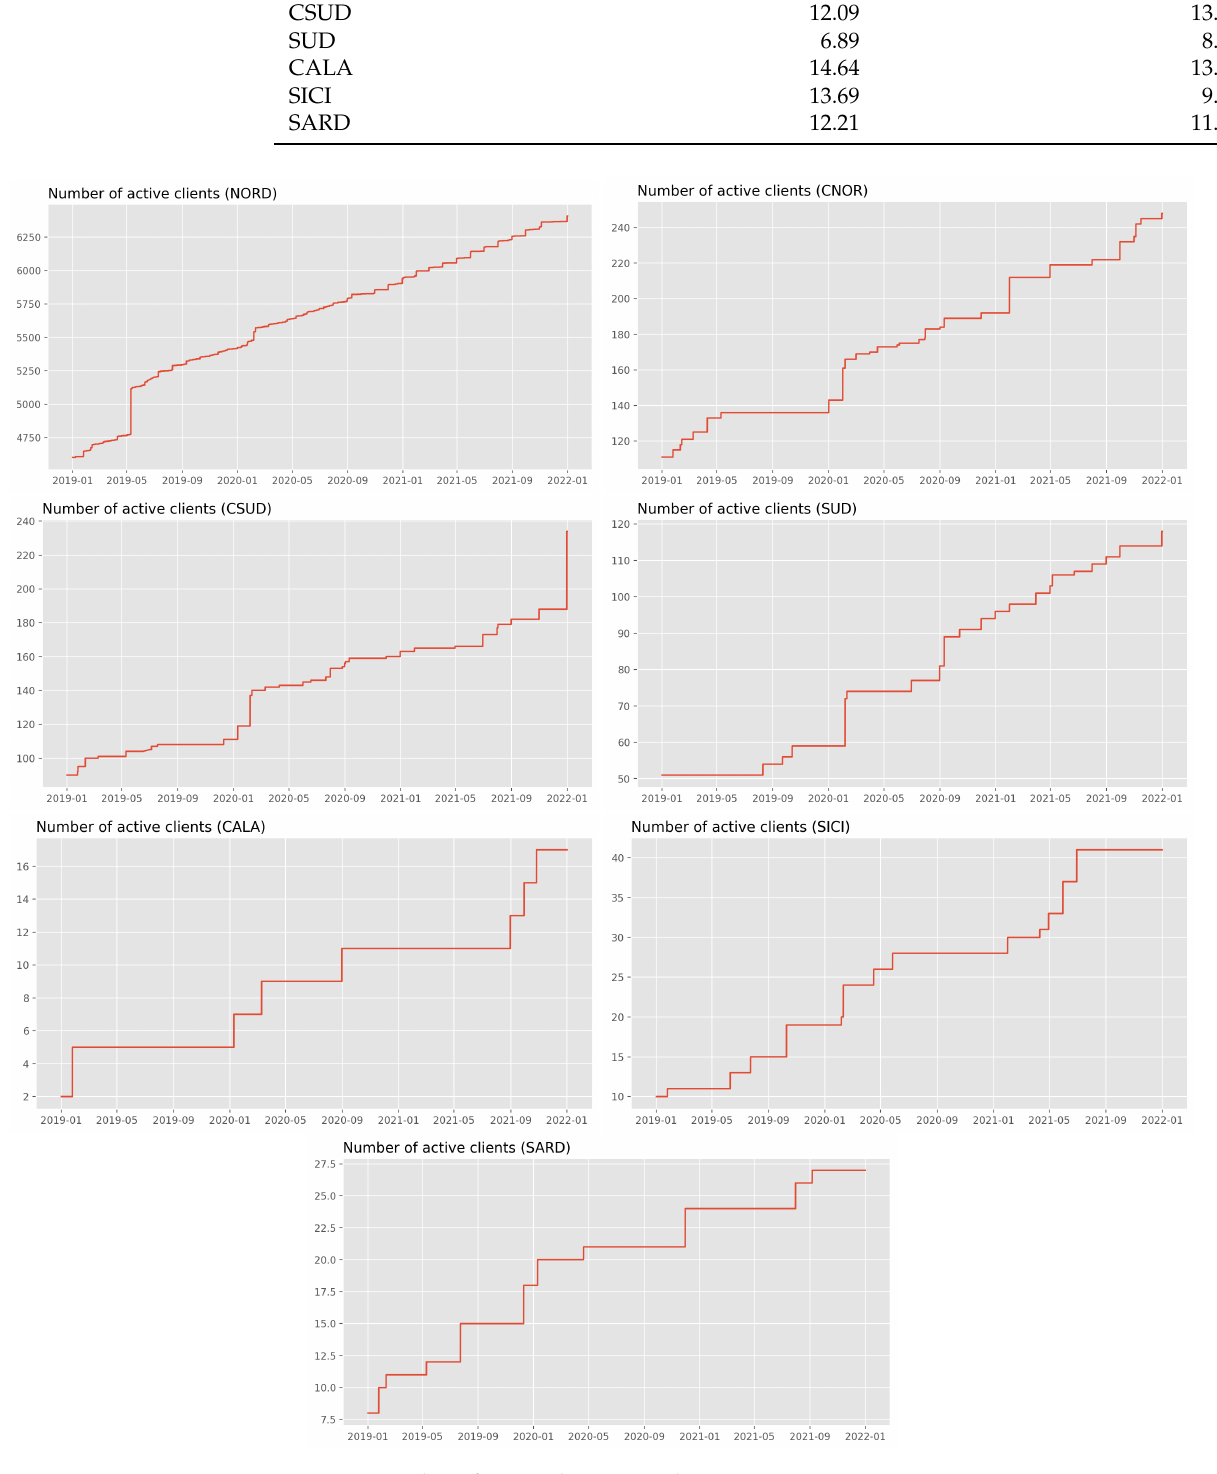
Figure 9. Number of active clients in each